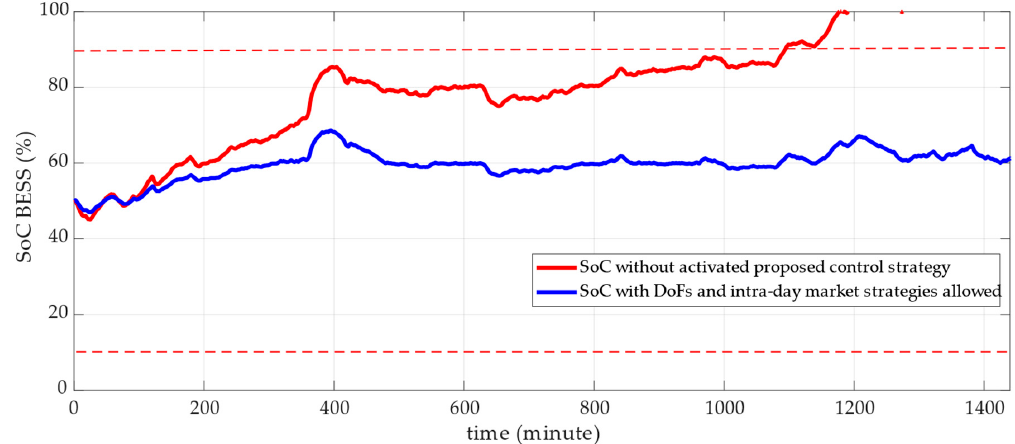
control strategies. Energies 2020 , 13 , x FOR PEER REVIEW without